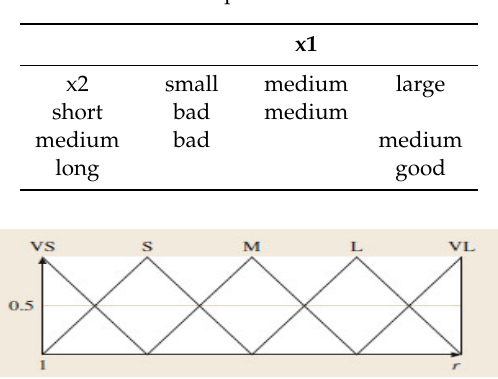
Figure 4. Example of a fuzzy partition where vs. -, S-, M-, L-, VL-.